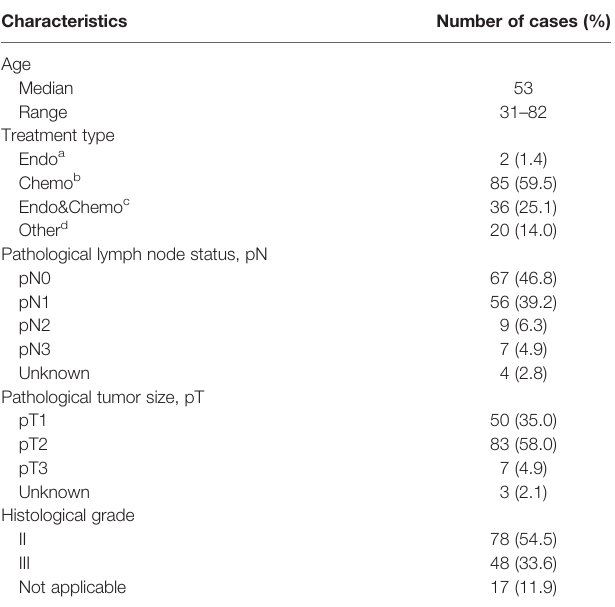
TABLE 1 | Clinicopathological characteristics of 143 Luminal-like